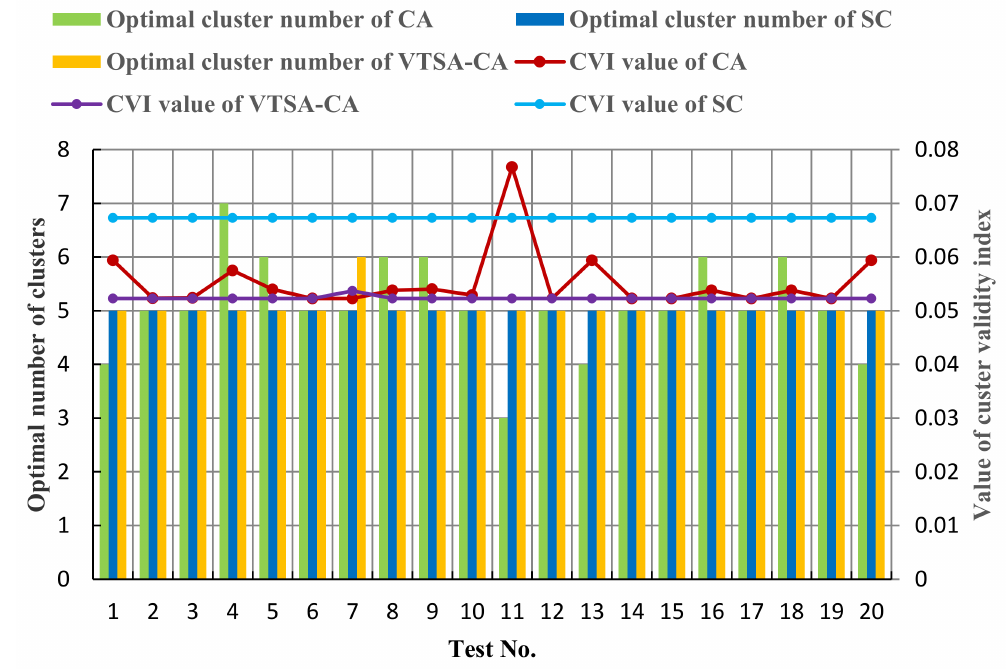
Figure 9. The comparison of the obtained optimal number of clusters in 20